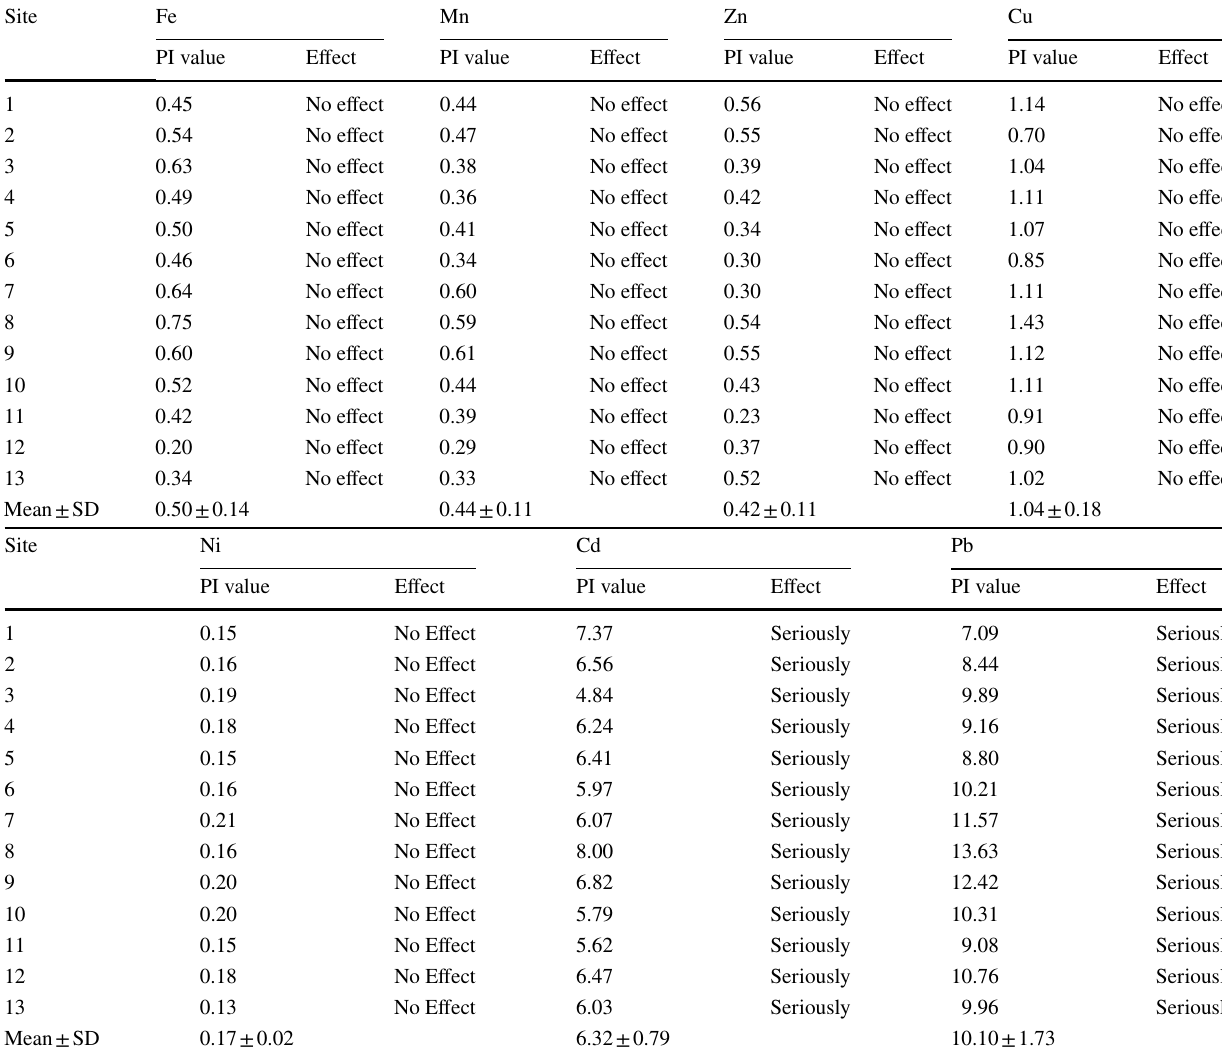
Table 5 Pollution index (PI) of the measured heavy metals in Mariout Lake water according to the guideline levels for aquatic life Site